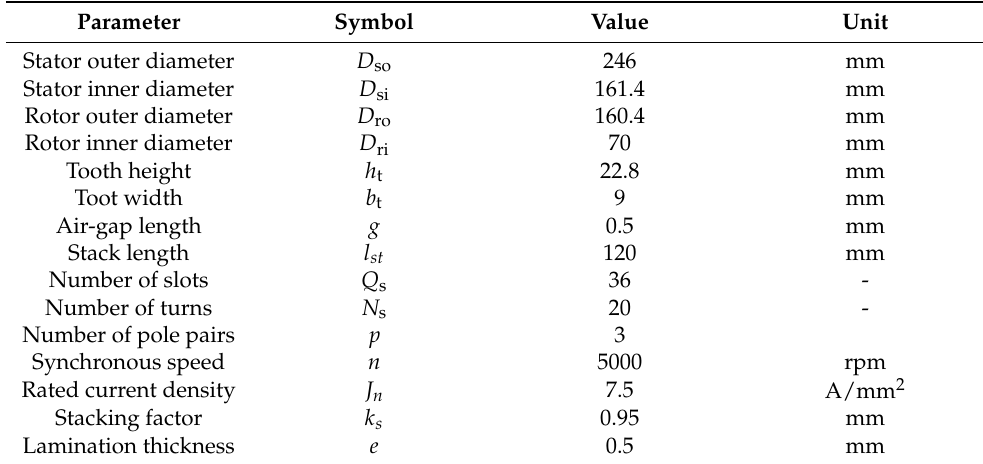
Table 9. Main data of the study-case machine subject to